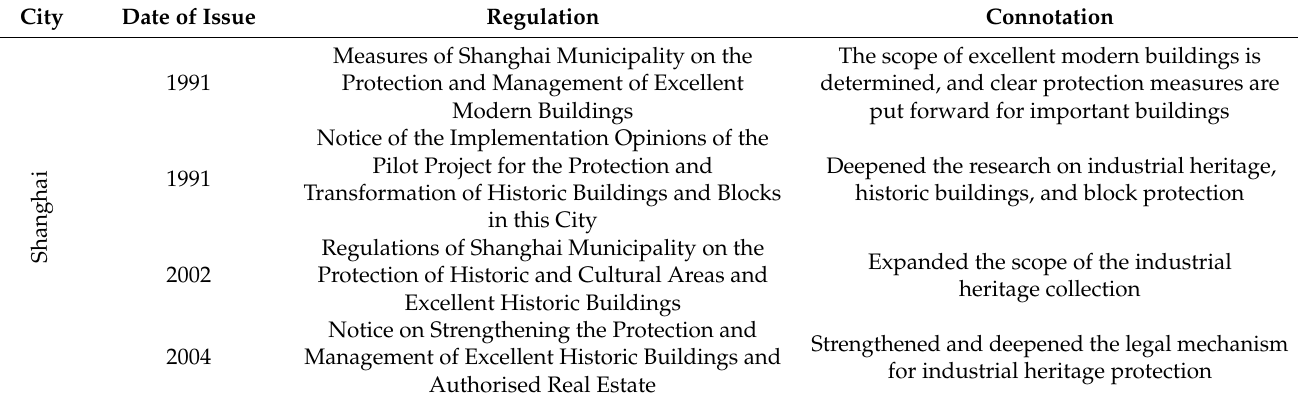
Table 3. Evolution of major legal provisions for the protection of industrial heritage in typical Chinese